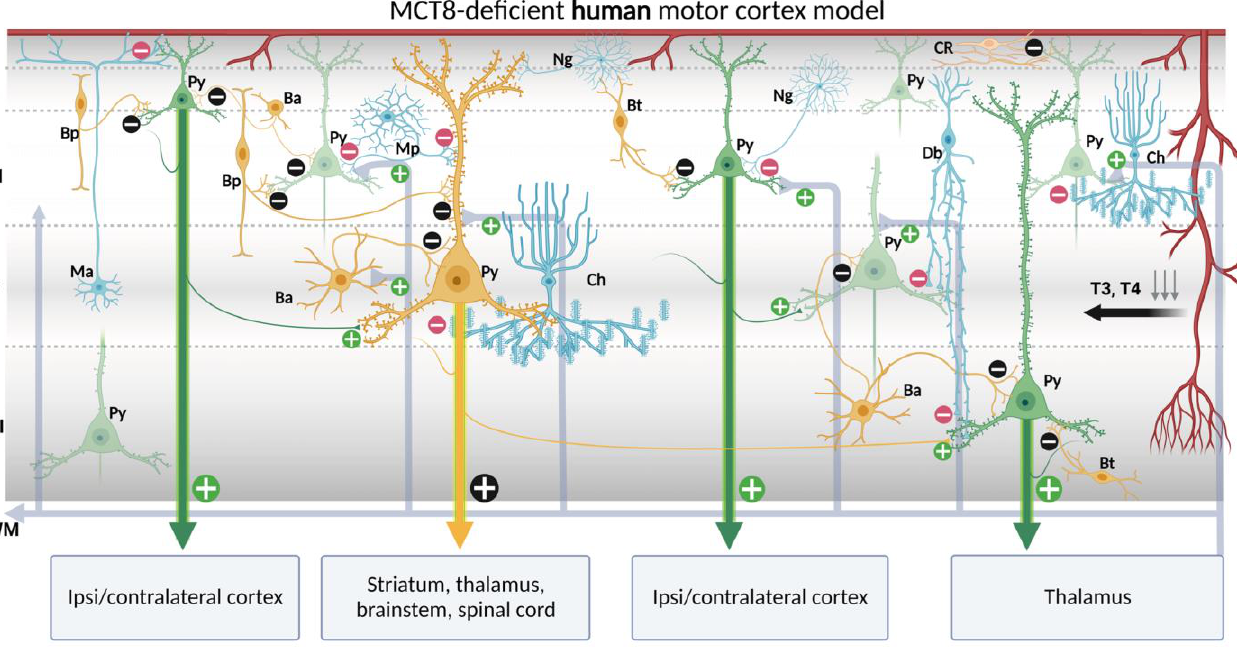
Figure 10. Models of human and macaque MCT8-deficient motor cortex. The models include our results and show possible cortical functional microcircuitry physiopathogenic mechanisms. A defi- ciency of MCT8, the most important route for circulating TH into the brain, results in a lack of TH throughout the brain. Pyramidal cells and interneurons expressing MCT8 are shown in yellow. Py- ramidal cells non-expressing MCT8 are shown in green and interneurons non-expressing MCT8 are